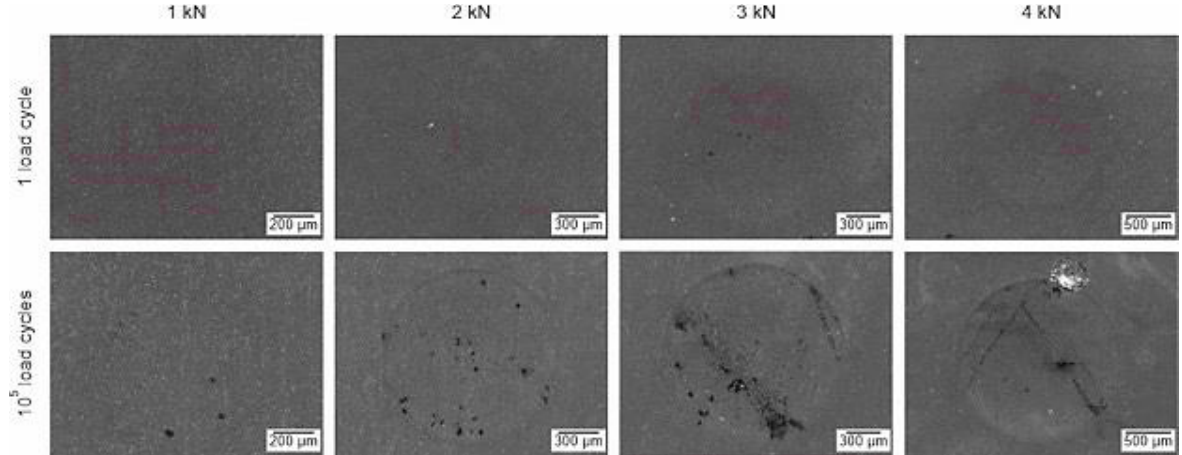
Figure 8. SEM images of the impacts for 1 and 4 kN and load cycles of 1 and 10 5 for the single-layer St-C system.